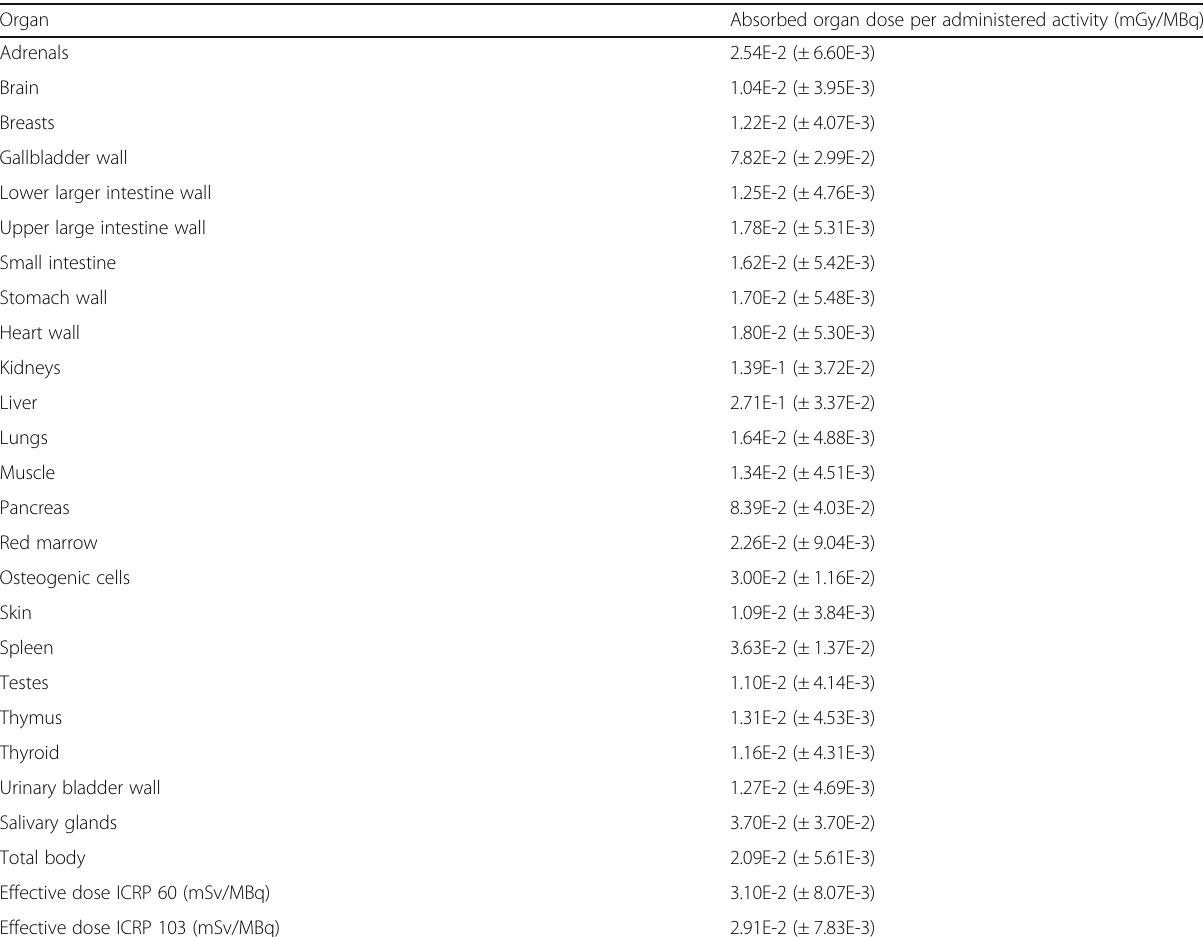
Table 2 Absorbed organs dose per administered activity (± SD) for 64 CuCl 2